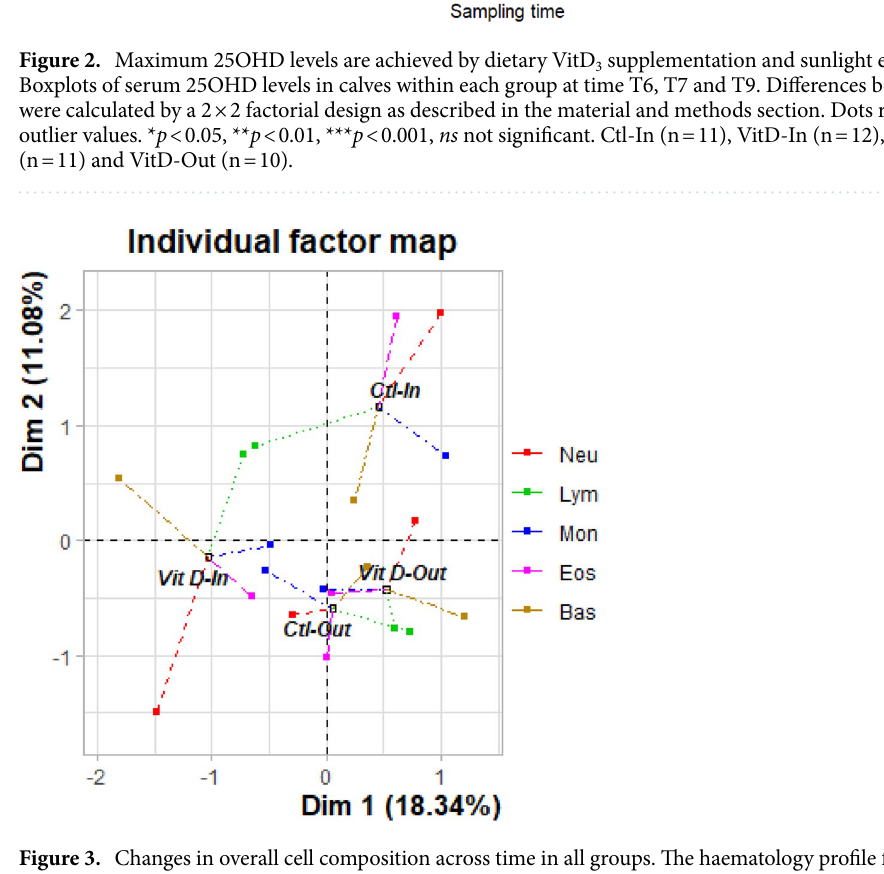
Figure 3. Changes in overall cell composition across time in all groups. The haematology profile for all time points was analysed by MFA as described in material and methods section. The individual factor map shows each group represented at the barycentre of their individuals. Individuals are projected on the side of the group of variables for which they have a high value, and opposite those variables for which they have low value. Lym, Bas and Mon are represented in Dim1, whereas Neu, Eos are represented in Dim2. Ctl-In (n = 11), VitD-In (n = 12), Ctl-Out (n = 12) and VitD-Out (n =